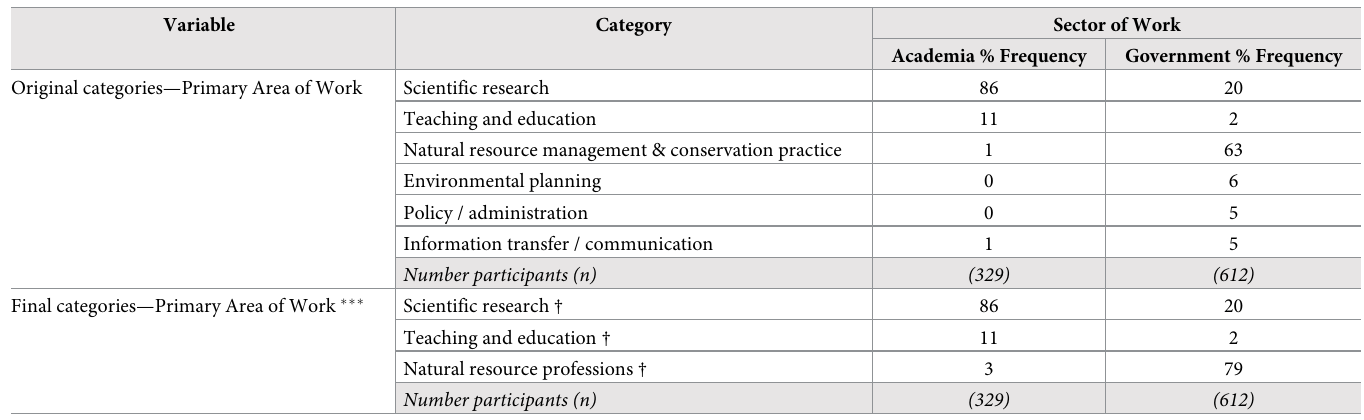
Table 3. Primary area of work of